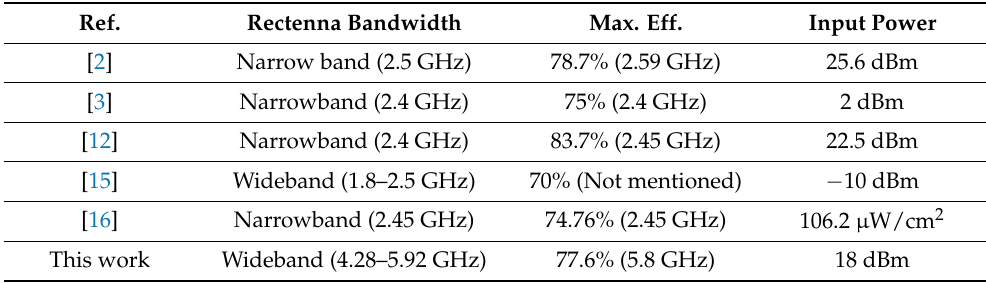
Table 1. Comparison of the